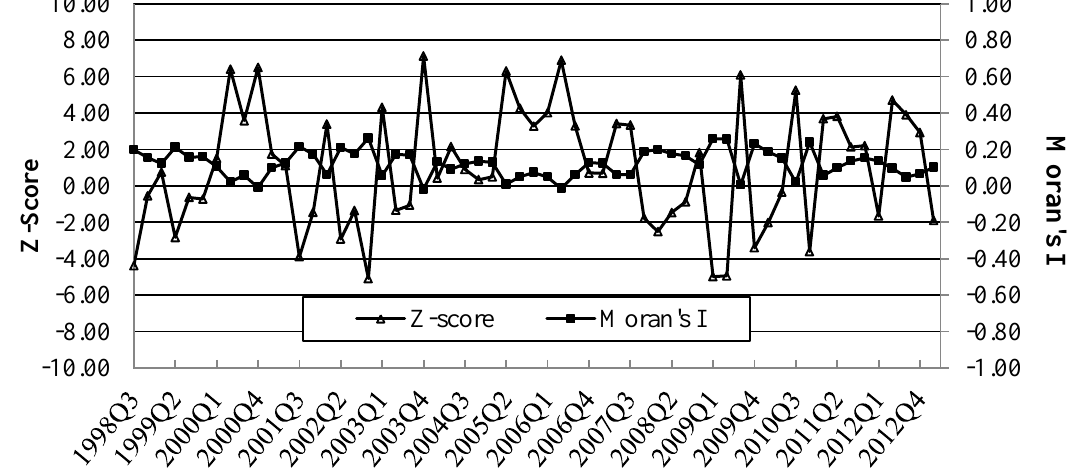
Figure 2 Spatial autocorrelation test for construction prices in eight regional markets Testing for Spatial Convergence in Australian Construction